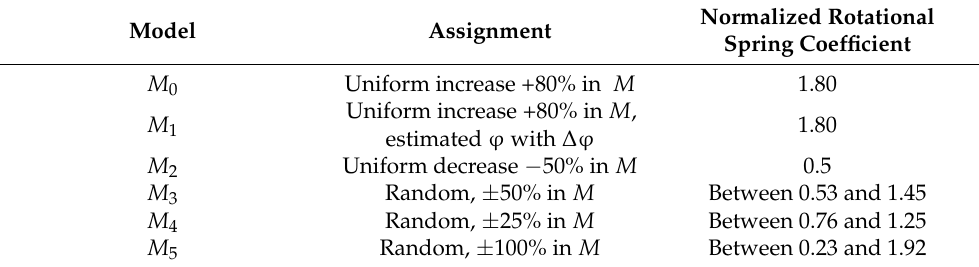
Table 1. Simulated